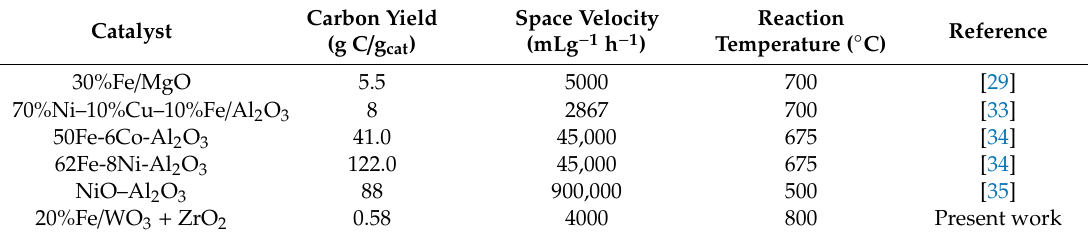
Table 3. Comparison of carbon yield of past related work with the present study.